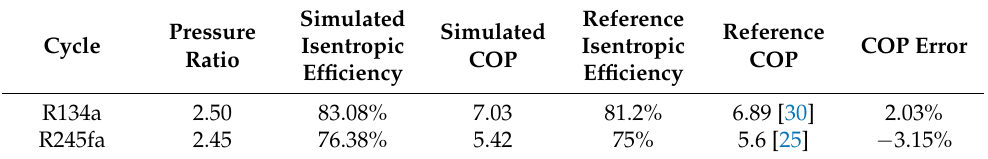
Table 2. Comparison of isentropic efficiency and